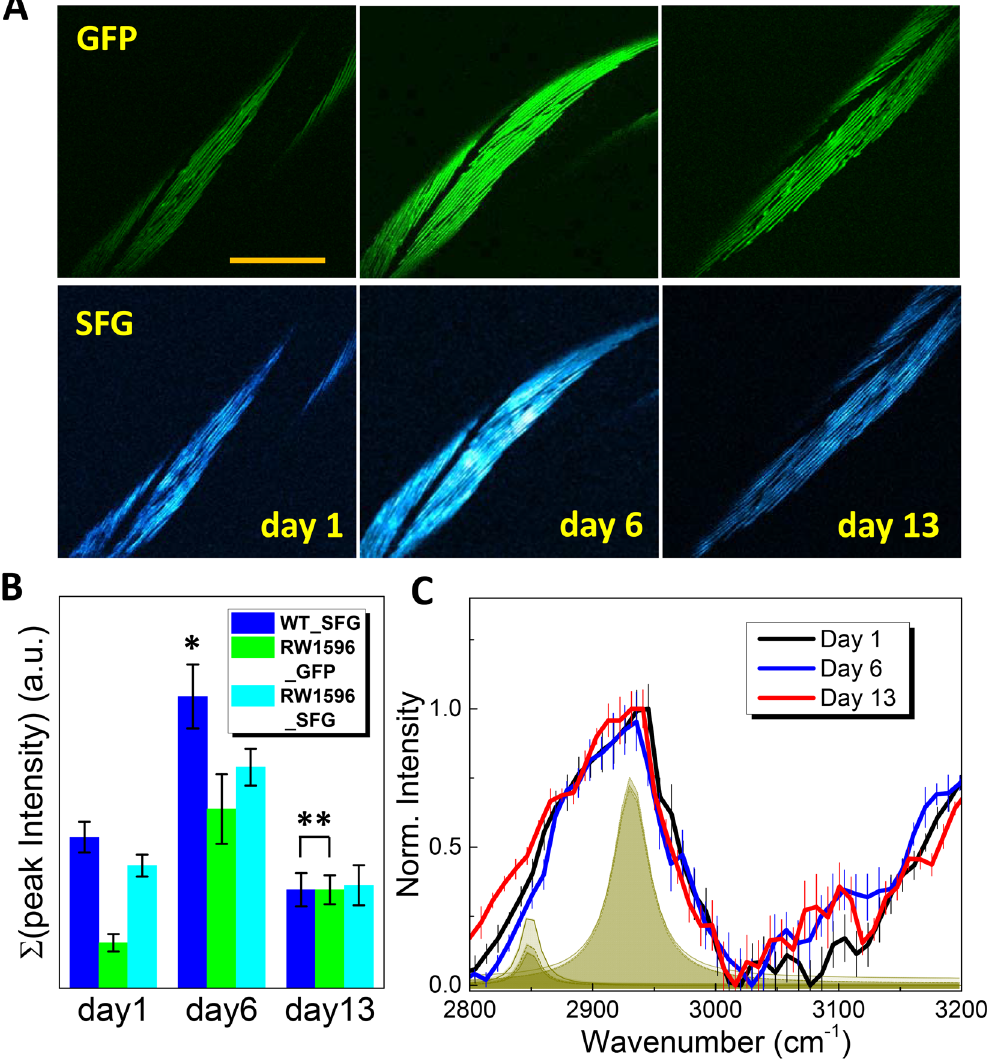
Figure 7. Spectrally focused CARS/SFG microspectroscopy as a technique to study muscle aging. ( A ) Two- photon excited luminescence of green fluorescent protein (GFP, upper panel) and SFG (lower panel) images of the body wall muscle in variously aged (1, 6, and 13 day-adulthood) RW1596 mutant animals. The scale bar represents 50 μ m. ( B ) Comparison of the summed peak intensity for the SFG and GFP images of WT and RW1596 mutant animals. The value of * was obtained from 7-day old WT worms. ** Two values are factored to be identical while the ratios among three intensity values from WT animals are retained. ( C ) Normalized spCARS intensity for 1-, 6-, and 13-day-old RW1596 mutant